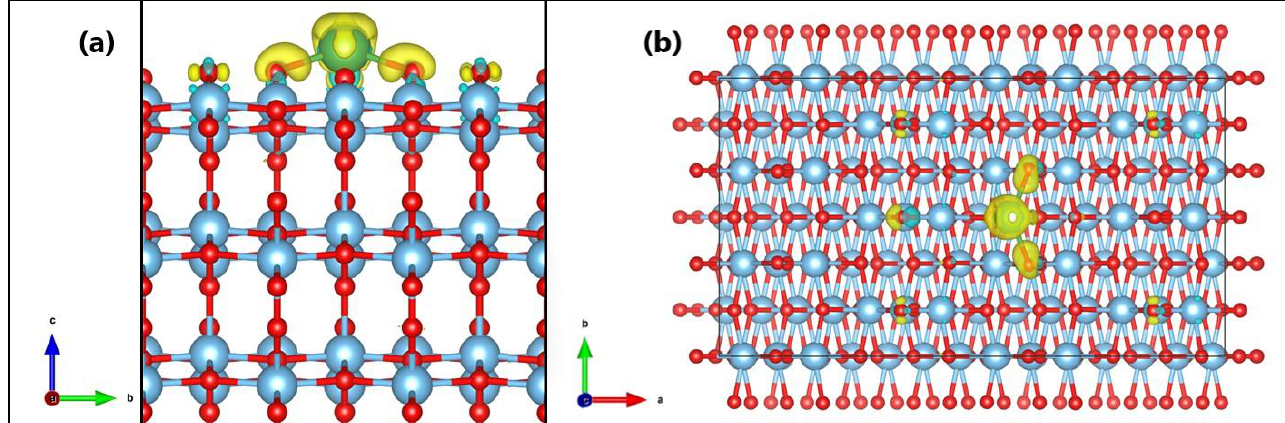
Figure 5. Charge density difference after La-doping on TiO 2. View from the ( a ) a and ( b ) z axes.